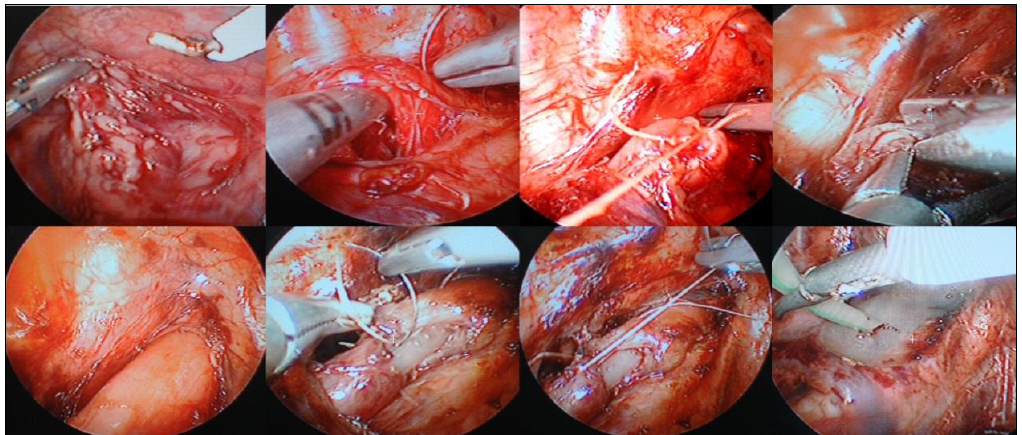
Figure 2: Different Stages of thoracoscopic TEF ligation and EA